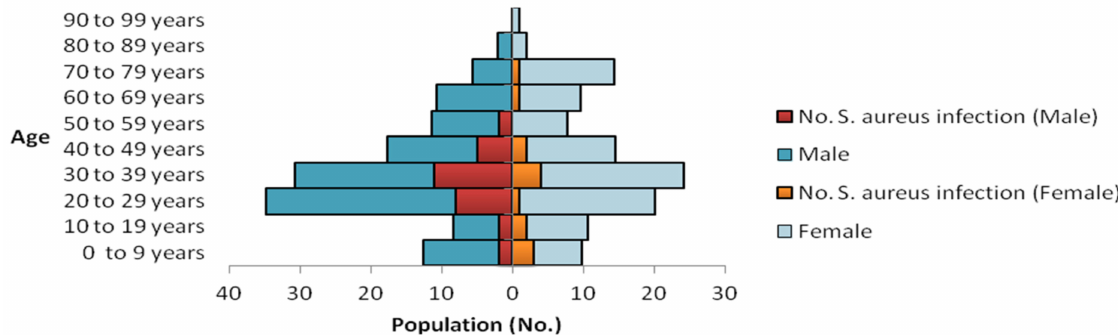
Figure 2. Population age–sex structure of the surgical inpatient cohort ( n = 325). Superposed within each age group is the age-group specific occurrence of S. aureus infection observed within the